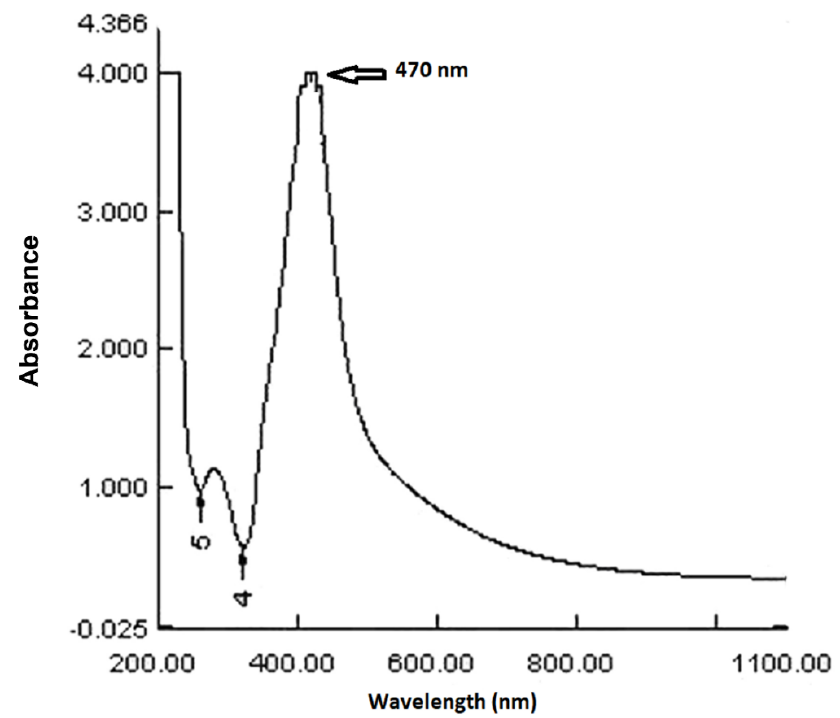
Figure 2 UV-visible spectrum of greenly synthesized Ag NPs . Figure 2. UV-visible spectrum of greenly synthesized Ag